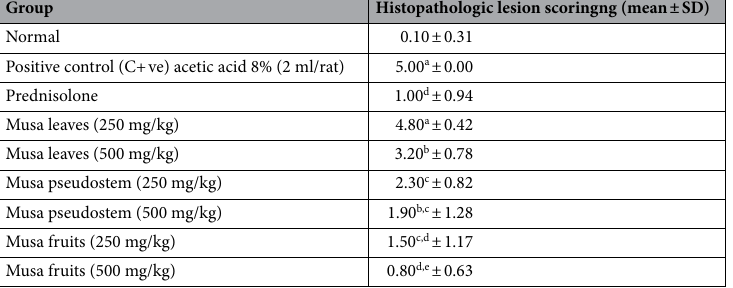
Table 5. Pathologic scoring of colon tissue damage assessed in the normal and treated groups.